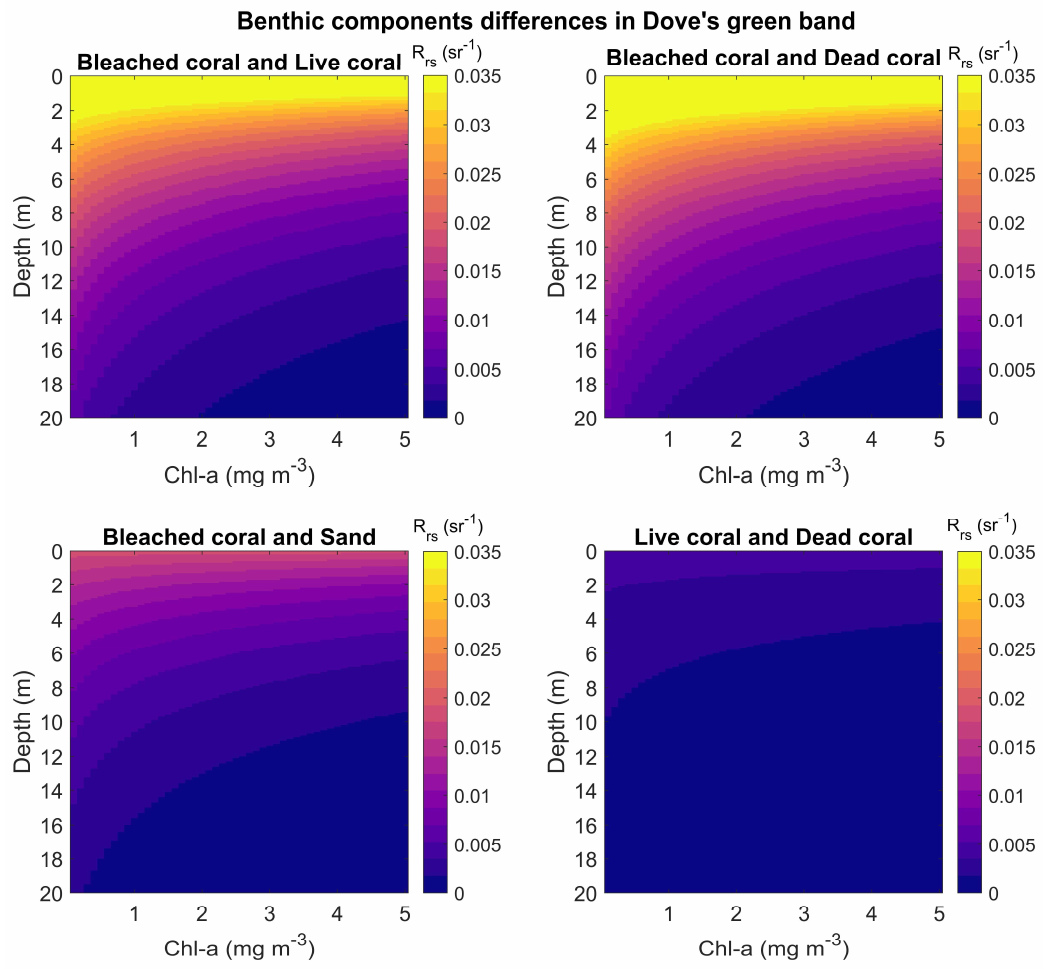
Figure 11. Di ff erences in remote sensing reflectance of di ff erent benthic components in Dove’s Figure 11. Differences in remote sensing reflectance of different benthic components in Dove’s green green band.